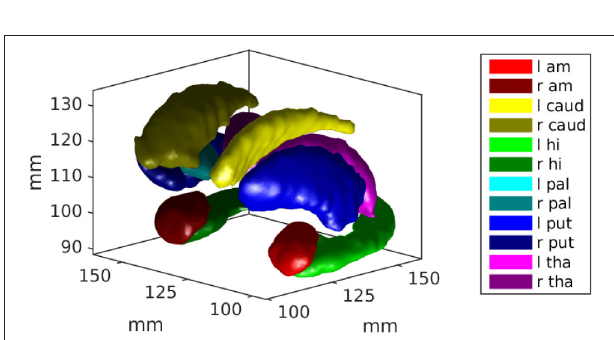
database (adni.loni.usc.edu). The ADNI was launched in 2003